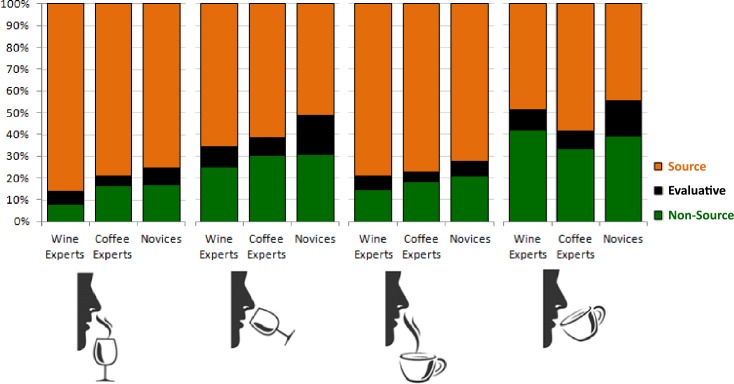
Description strategies used by wine experts, coffee experts and novices.Overall, experts and novices overwhelmingly relied on source-based descriptions (orange). However, wine experts used relatively more source-based terms to describe the smell and flavor of wine, and coffee experts used relatively more source-based terms to describe the flavor of coffee. Novices used more evaluative terms than the experts (black) to describe the smell and flavor of both coffee and wine.